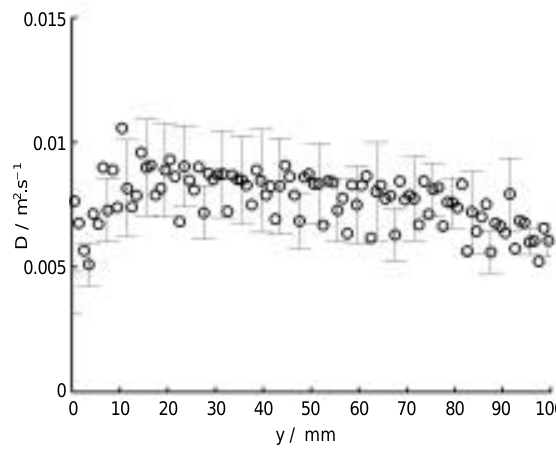
Self-diffusion coefficient as a function of altitude, extracted from the displacement probability functions using equa- tion (6). Error bars, representing the standard deviation of the mean, are shown for a sample of data